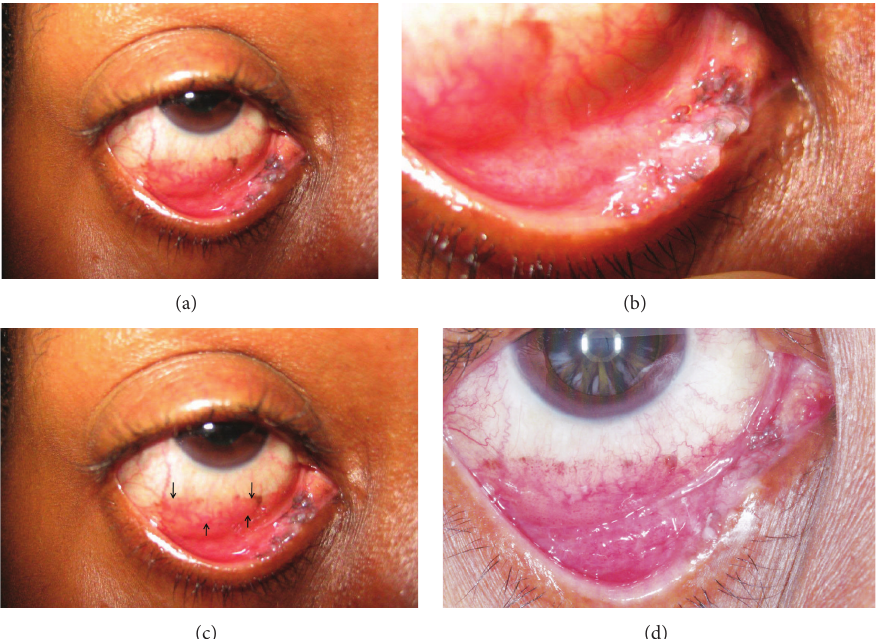
Figure 1: (a)-(b) show partially pigmented papillary tarsal tumor, right lower lid. (c) Region of fine epibulbar papillary tumor (arrows). (d) Tumor has resolved following 2 months of treatment.